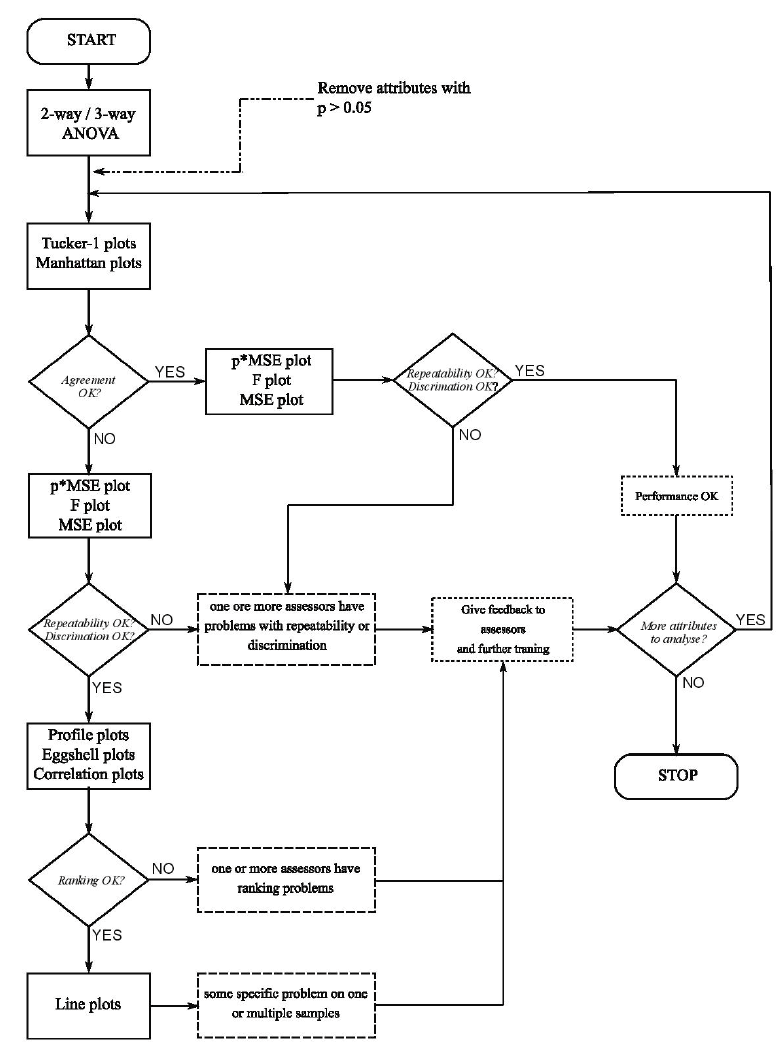
Figure 3. The workflow of the PanelCheck [13].